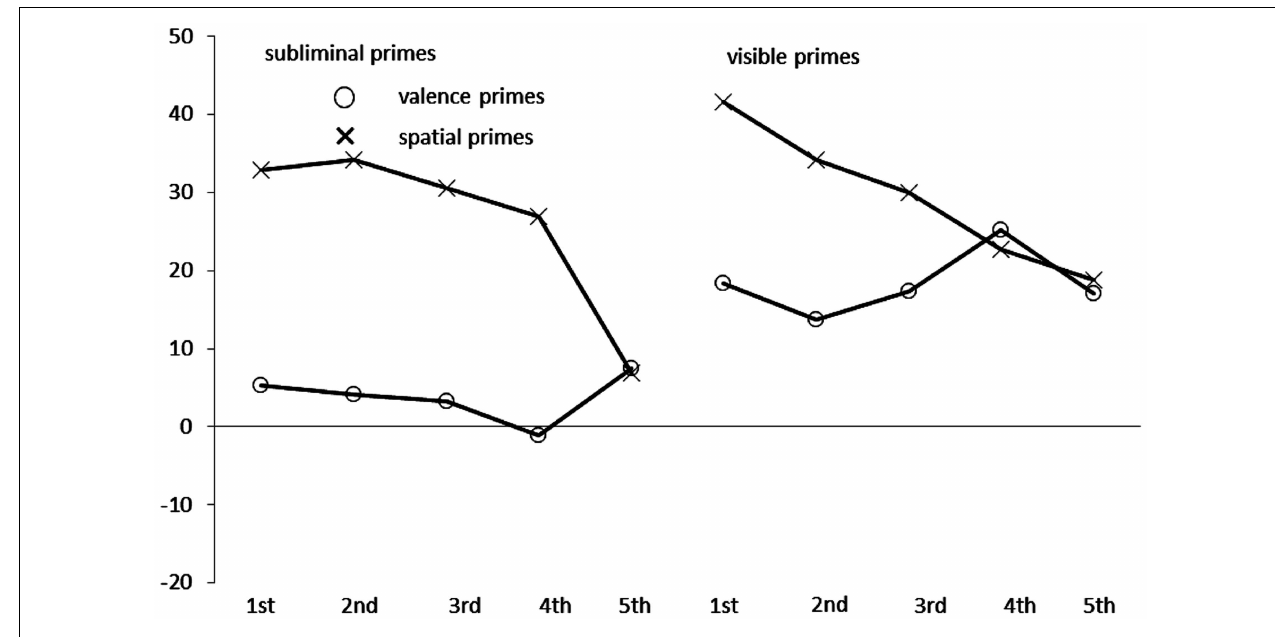
FIGURE 3 | Mean congruence effects in milliseconds, calculated as mean correct ReactionTimes (RTs in ms) of incongruent conditions minus mean correct RTs of congruent conditions in Experiment 2, as a function